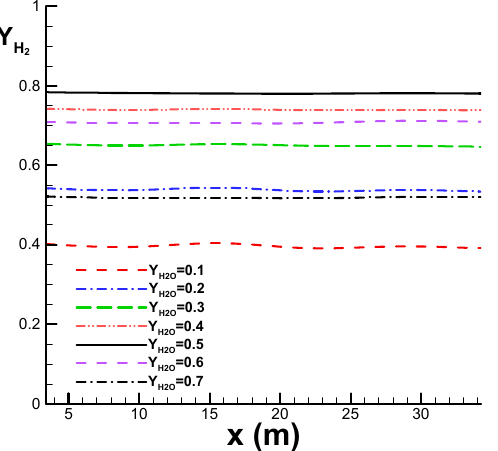
Figure 5. Comparison of the average mole fractions of hydrogen at the reforming tube outlets using different mole fractions of steam.